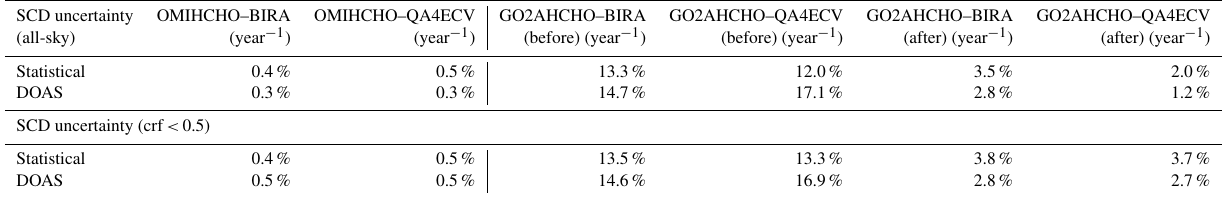
Table 8. Yearly increase of the statistical and DOAS uncertainty estimates of OMI and GOME-2A HCHO SCDs for OMIHCHO–BIRA and OMIHCHO–QA4ECV (Pacific orbit from day 1 of January, April, August, October (or closest available data) 2007–2015), and for GONO2A-BIRA and GONO2A–QA4ECV (Pacific orbit from day 1 of January up to December and from day 15 of January, April, July, and October 2007–June 2014 and 2007–2015, respectively) for the sub-periods before and after the second throughput test (September 2009), for all-sky conditions (top panel) and clear-sky conditions (bottom panel). The GO2AHCHO–BIRA data are provided only for scenes with cloud fraction lower than 0.4; therefore the clear-sky conditions yield similar SCD uncertainties to the all-sky conditions. SCD uncertainty OMIHCHO–BIRA OMIHCHO–QA4ECV GO2AHCHO–BIRA GO2AHCHO–QA4ECV GO2AHCHO–BIRA GO2AHCHO–QA4ECV